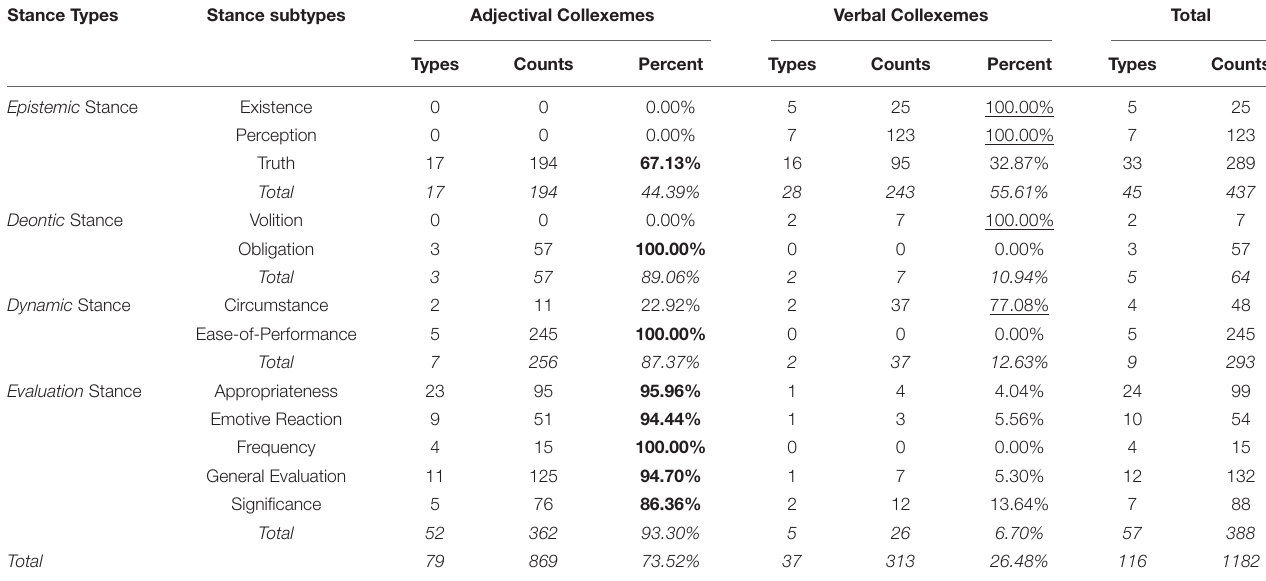
TABLE 1 | Adjectival and verbal collexemes for stance